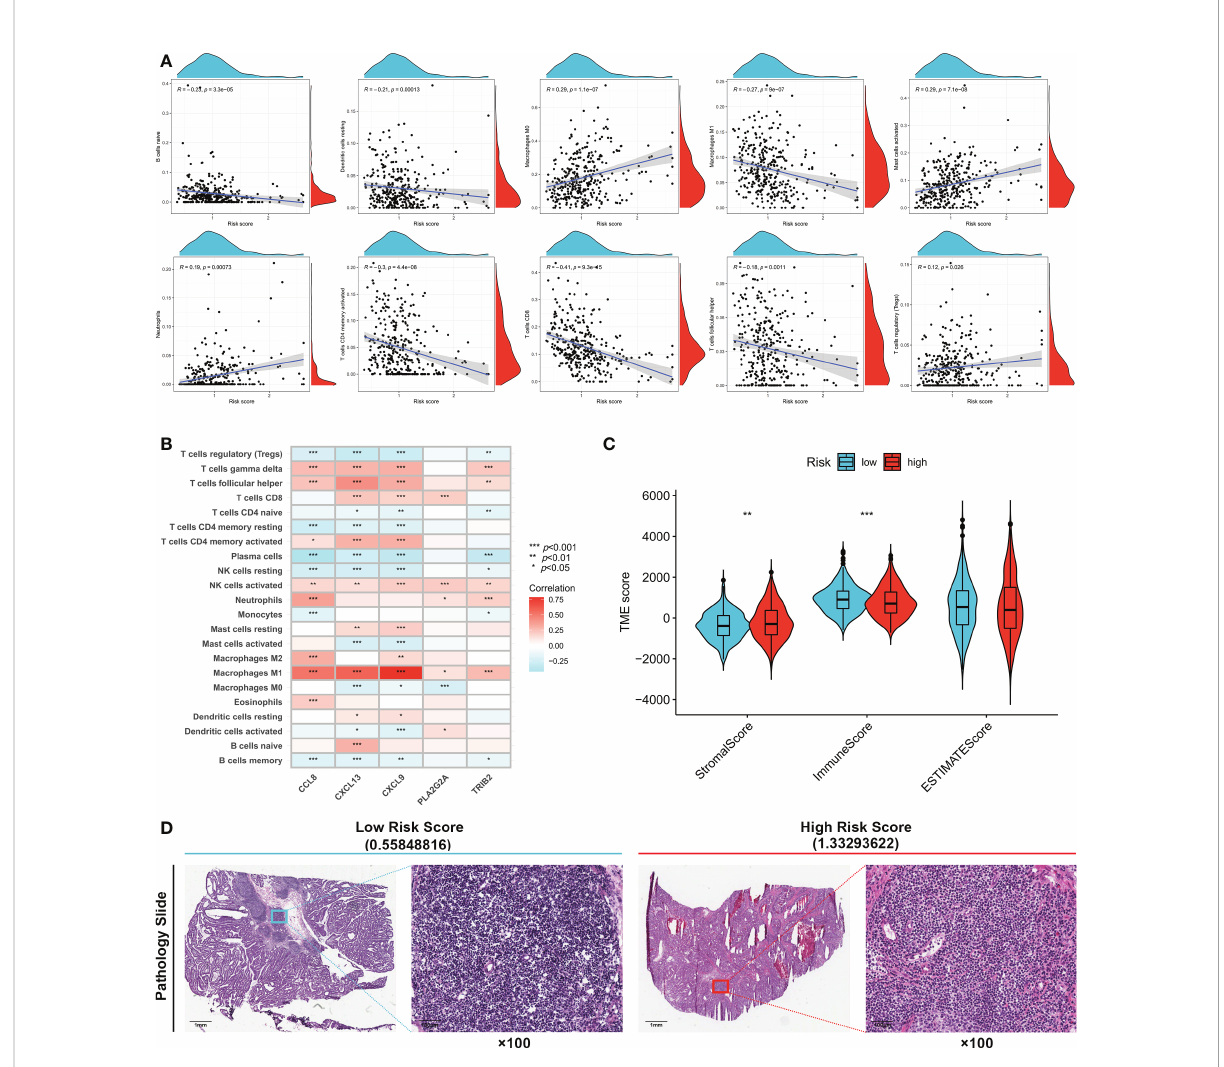
FIGURE 5 Evaluation of tumor microenvironment in high- and low- risk groups. (A) Relationship between risk score and different immune cell types. (B) Correlation between the abundance of immune cells and fi ve genes in the prognostic signature. (C) Correlation between risk score and immune-related scores. (D) TCGA Pathology Slides con fi rmed that immune cell in fi ltration was greater in the tumor of low-risk patients than in high-risk patients. * p < 0.05; ** p < 0.01; and *** p <